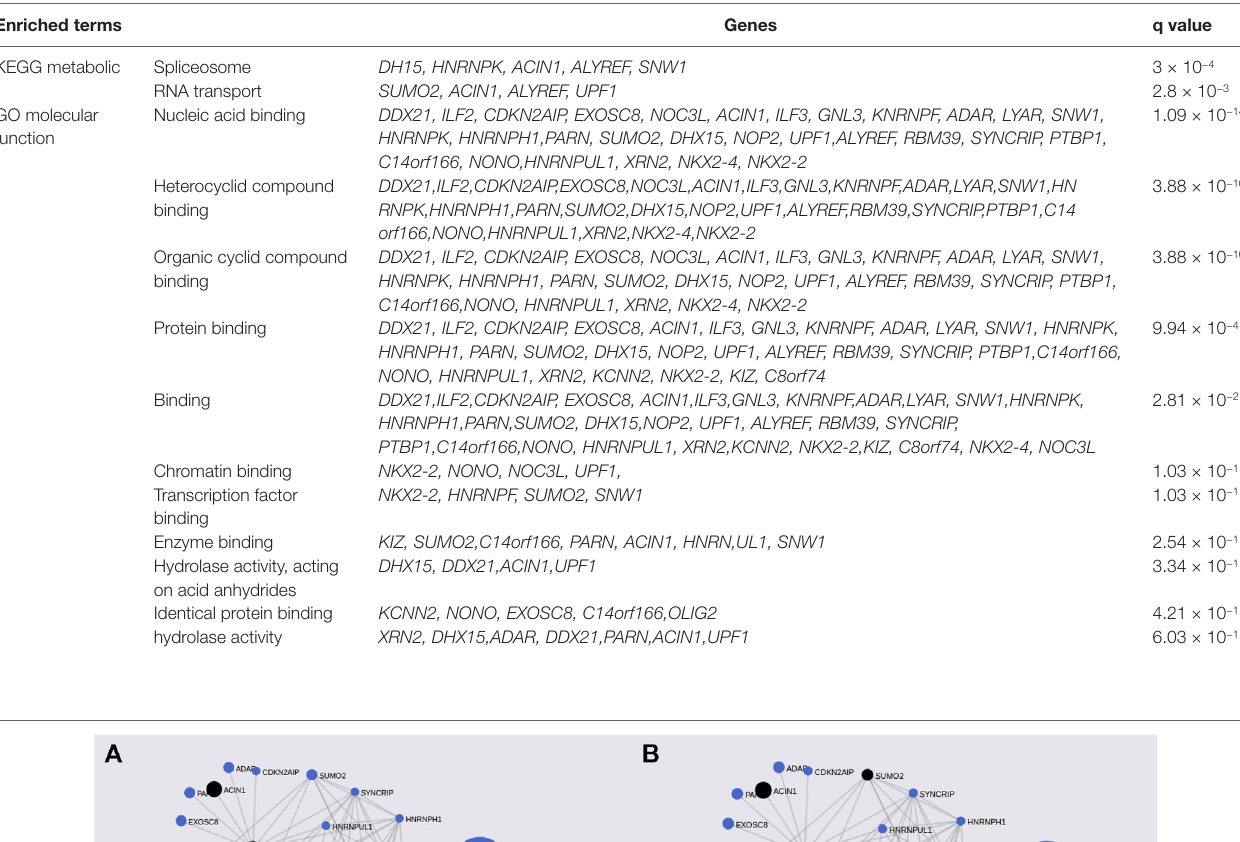
TABLE 5 | Enriched terms for query ASD genes and its interactors (subnetwork genes) according to FunCoup.